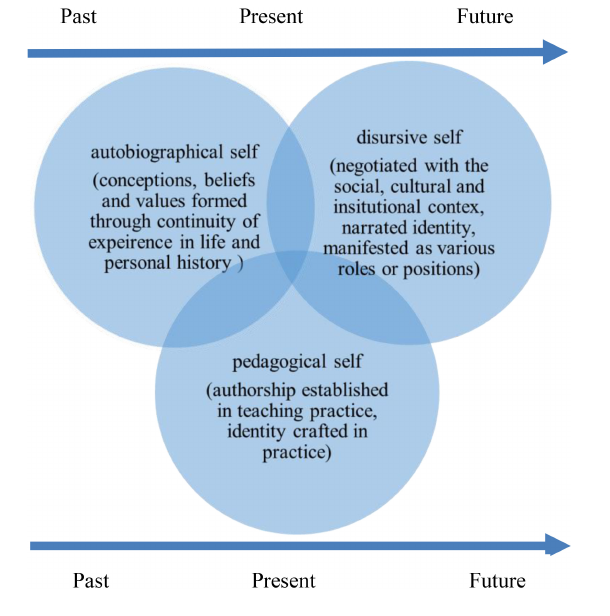
FIGURE 2 | The three selves: a holistic interactional